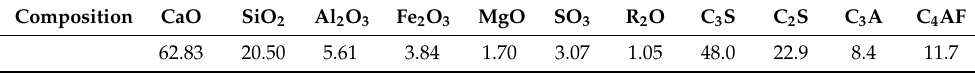
Table 1. Chemical and mineralogical compositions of Portland cement (wt.%).